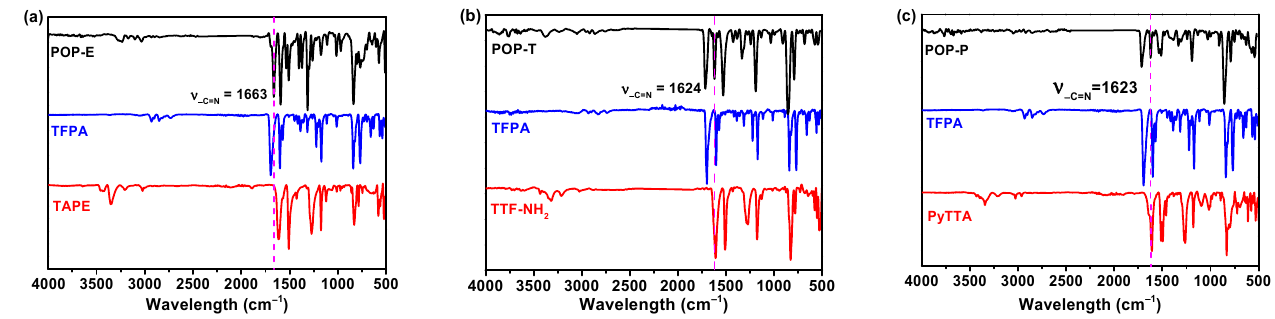
Figure 1. FT-IR spectra of TAPE, TFPA and POP-E ( a ), TTF-NH 2 , TFPA and POP-T ( b ) and PyTTA, TFPA and POP-P ( c ).